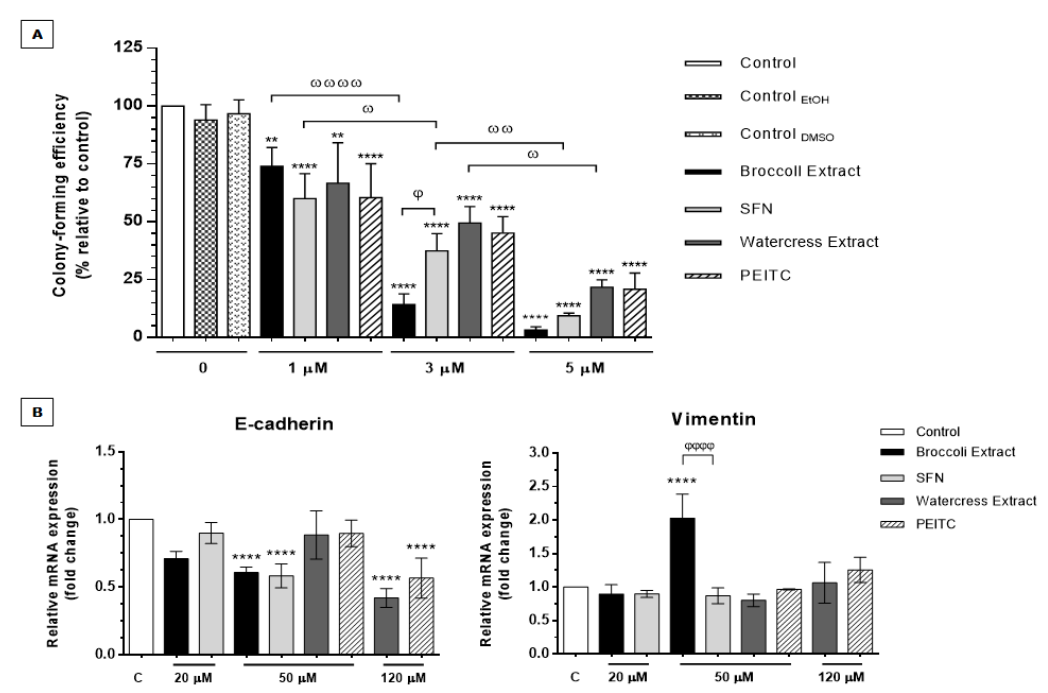
Figure 6. Inhibitory effects of natural extracts and ITCs in anchorage ‐ independent cell growth using cells derived from HT29 spheroids. ( A ) Inhibition of anchorage ‐ independent cell growth upon a 2 ‐ week treatment with natural extracts and ITCs normalized relatively to control without treatment or solvent (100% colony formation efficiency). ** p < 0.01 and **** p < 0.0001 are relative to control; ω p < 0.05, ωω p < 0.01, ωωωω p < 0.0001 are relative to the same compound; φ p < 0.05 is relative to broccoli extract; ( B ) Analysis of CDH1 and VIM expression (coding for E ‐ cadherin and Vimentin, respectively) by qPCR in HT29 spheroids treated with natural extracts and ITCs for 24 h; data normalized relatively to treatment with the same % ( v / v ) of solvent used for each extract/compound. GAPDH was used as endogenous control. In the case of the extracts’ EC 50 values (50 and 120 μ M for broccoli and watercress extracts, respectively) results are expressed as mean of two independent experiments performed in triplicate ± SD. For the tested dose bellow the EC 50 value, the results are expressed as mean of one experiment performed at least in triplicate ± SD. **** p < 0.0001 is relative to control; φφφφ p < 0.0001 is relative to broccoli extract.